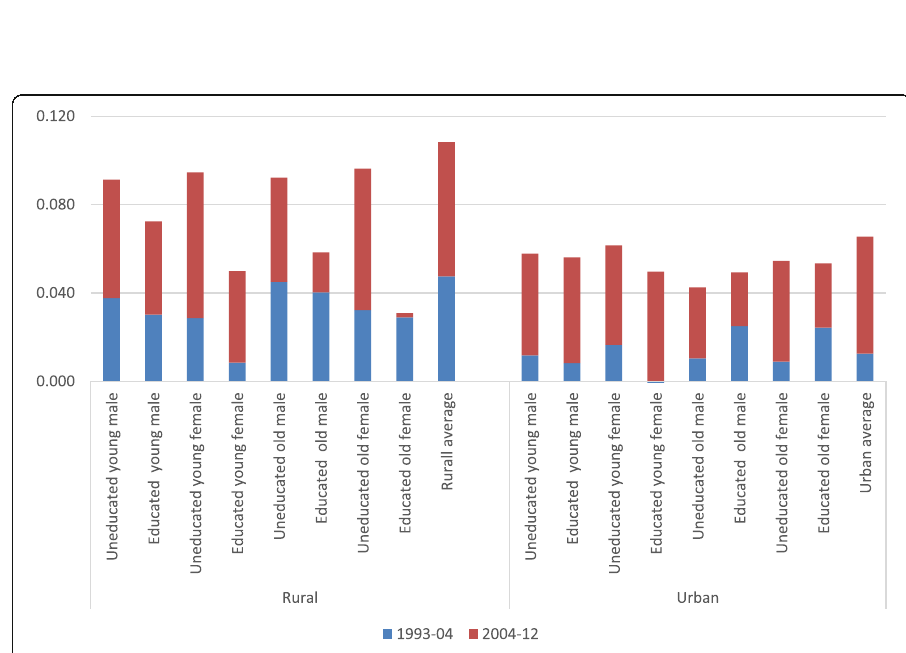
Fig. 4 Annual average real wage changes by demographic group